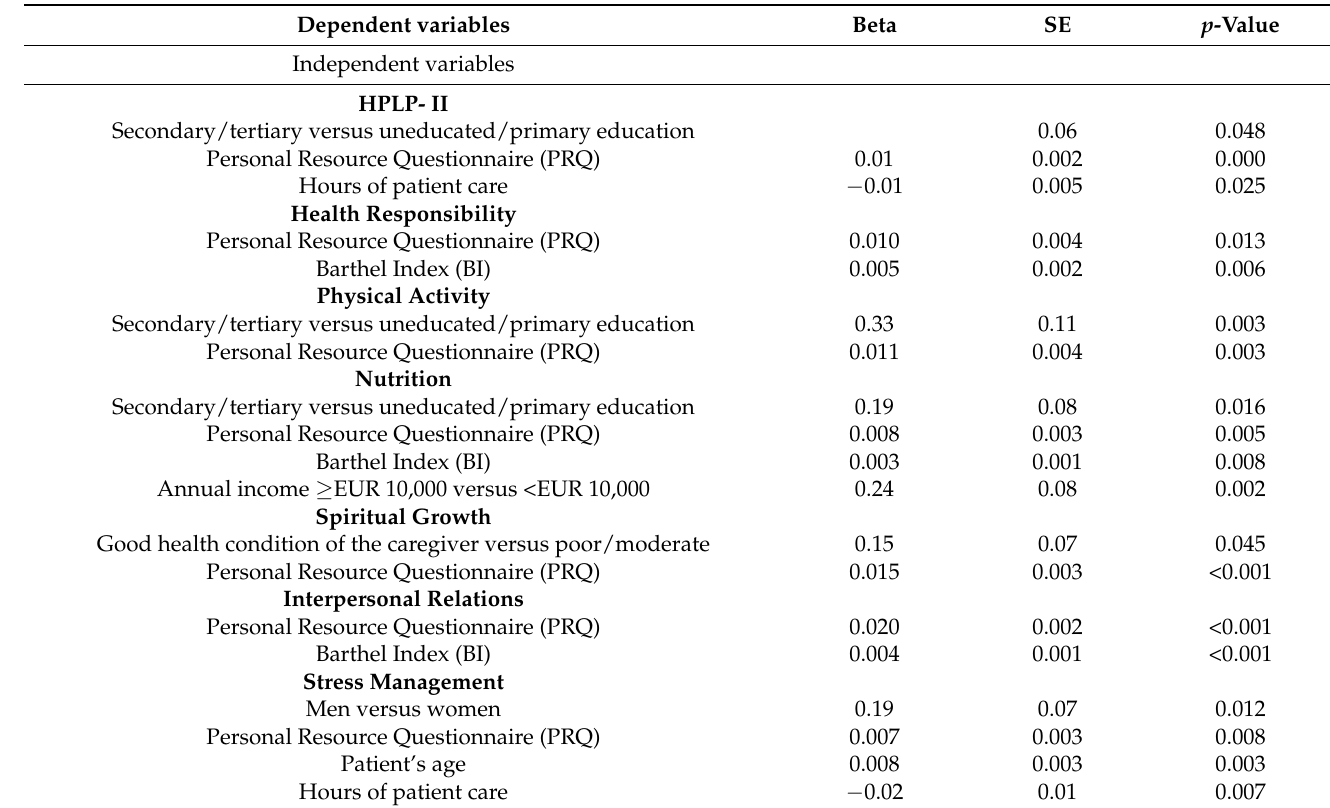
Table 4. Multivariate analysis of HPLP-II